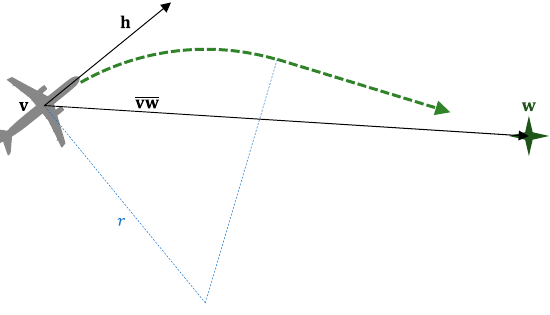
Figure 3. Turn direction computation.